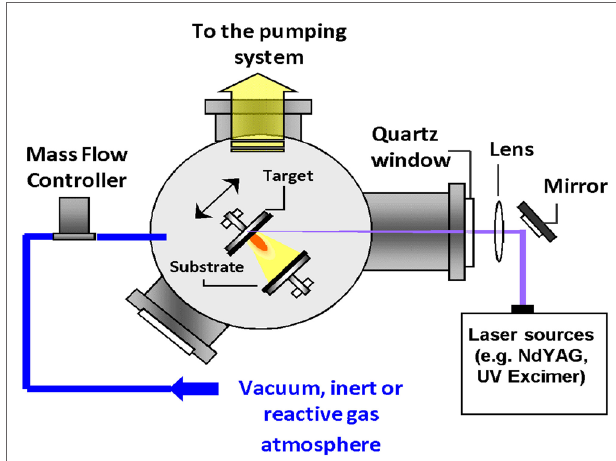
FiGURe 7 | Schematic of a representative laser deposition tool .